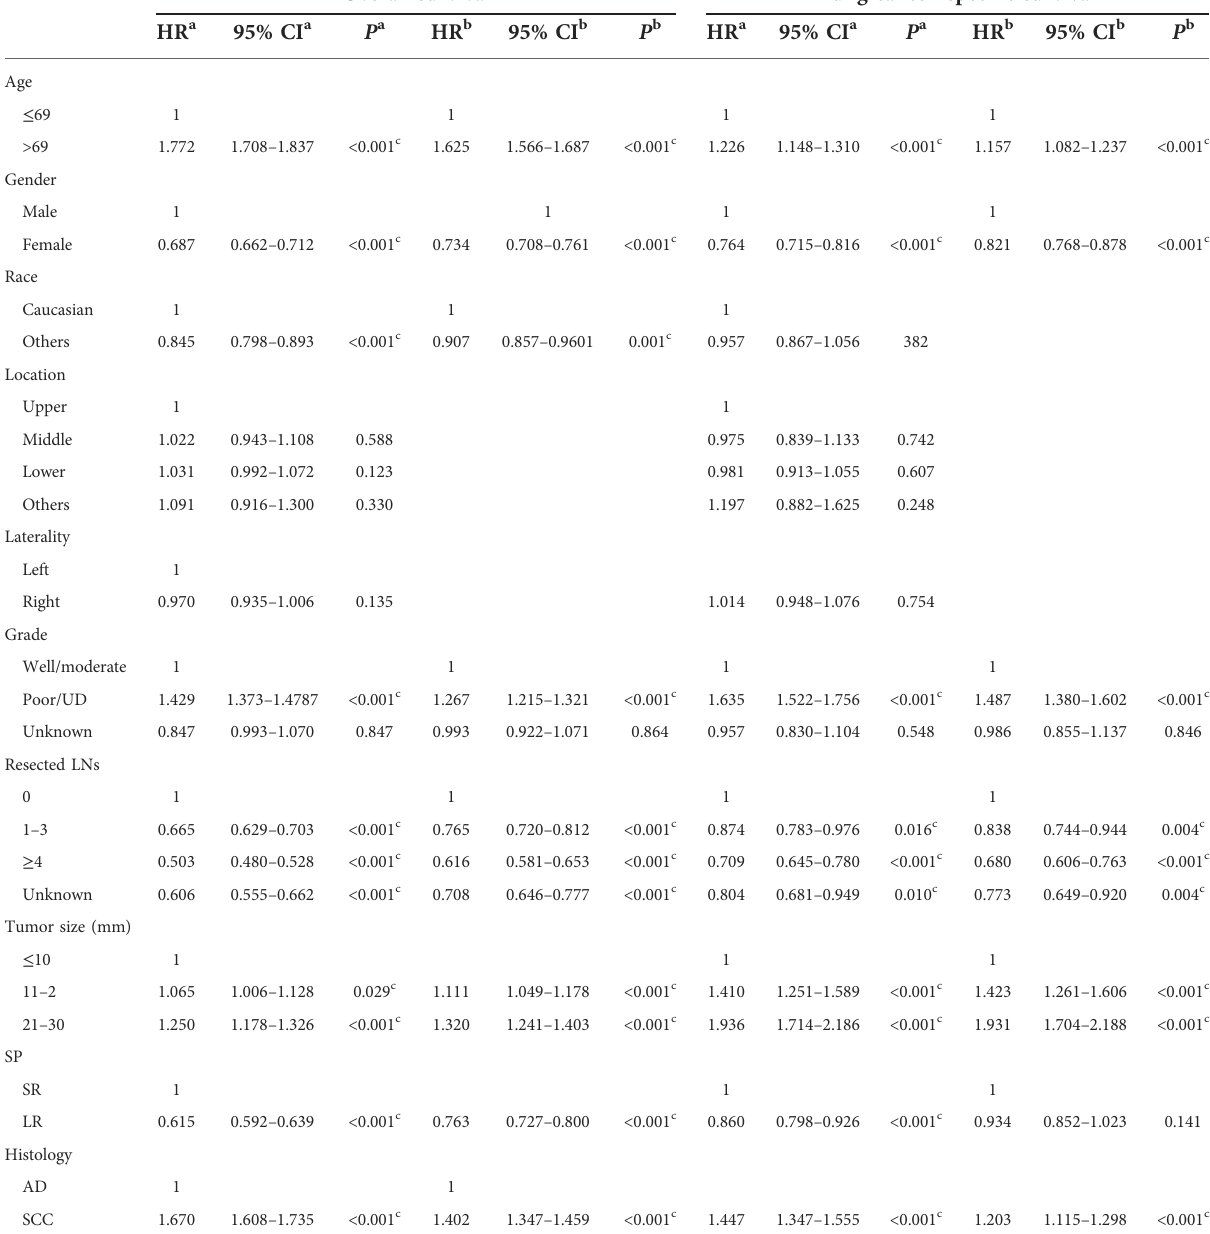
TABLE 2 Univariate and multivariate regression analyses for overall survival and lung cancer – speci fi c survival before